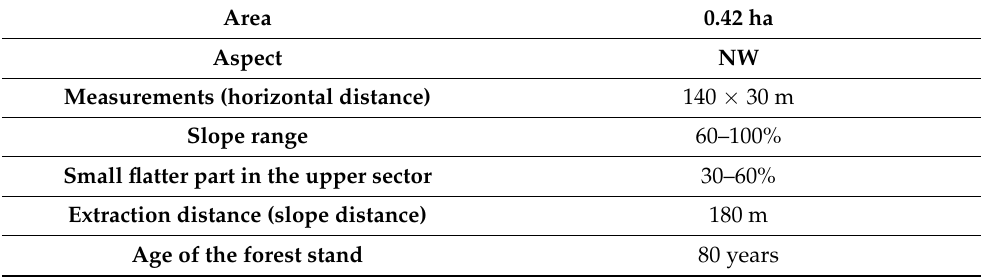
Table 1. Characteristics of the harvesting area.